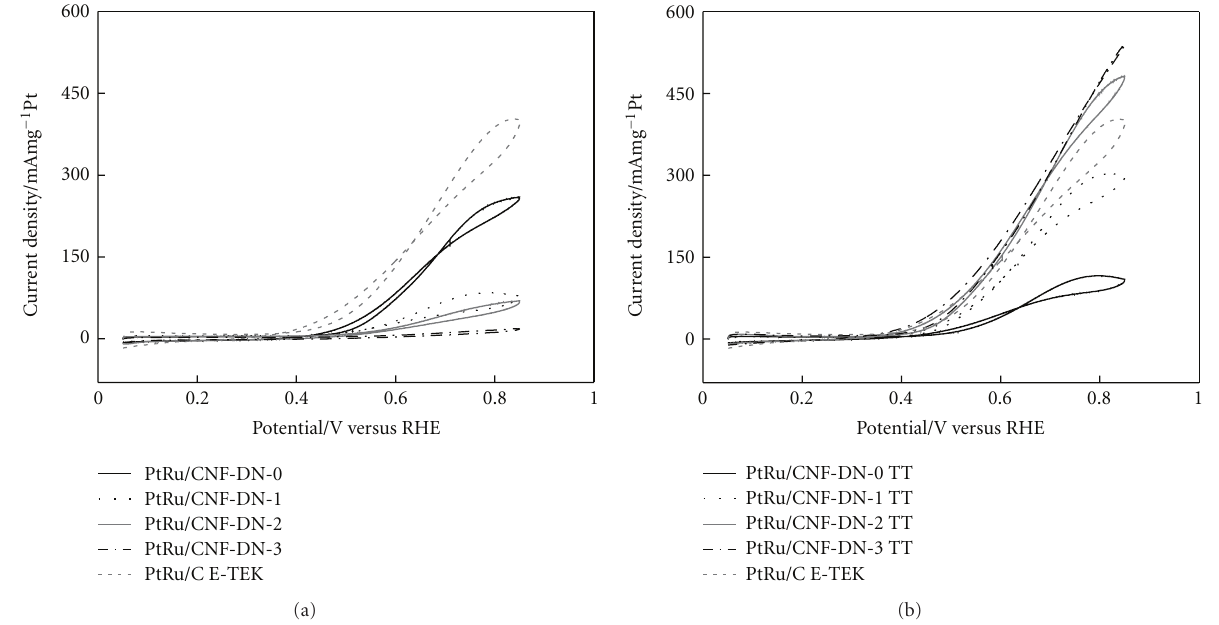
Figure 6: Cyclic voltammograms for methanol oxidation at room temperature on Pt-Ru synthesized catalysts. (a) Untreated catalysts (b) Heat-treated catalysts. Scan rate: 20 mVs − 1 . Supporting electrolyte: 0.5M H 2 SO 4 . Methanol concentration: 2.0 M.